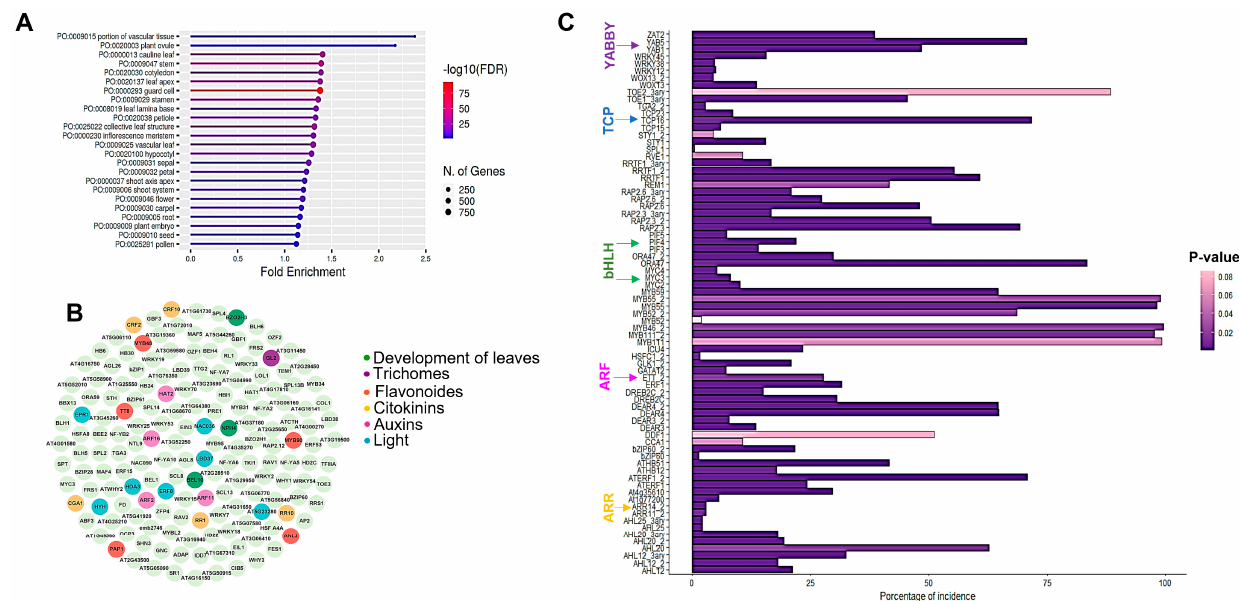
Figure 1. Putative target genes of SPT in leaves are related to the development of leaves, trichomes, anthocyanin, and other processes. ( A ) Enrichment analysis based on GO plant category, showing categories related to leaves, guard cells, and aerial parts of the plant. ( B ) Putative target genes of SPT that code for transcription factors related to leaf development and other developmental processes described for SPT involvement. ( C ) Result of enrichment promoter analysis of putative target genes of SPT that shows domains related to transcription factor families related to various processes, e.g., leaf development based on the Francisco-Zorrilla 2014 database [36]. Furthermore, by analyzing other SPT target genes, we also identified some genes re- lated to the formation of or expressed in stomata, trichomes, and flavonoid biosynthesis; leaves (Figure 2).